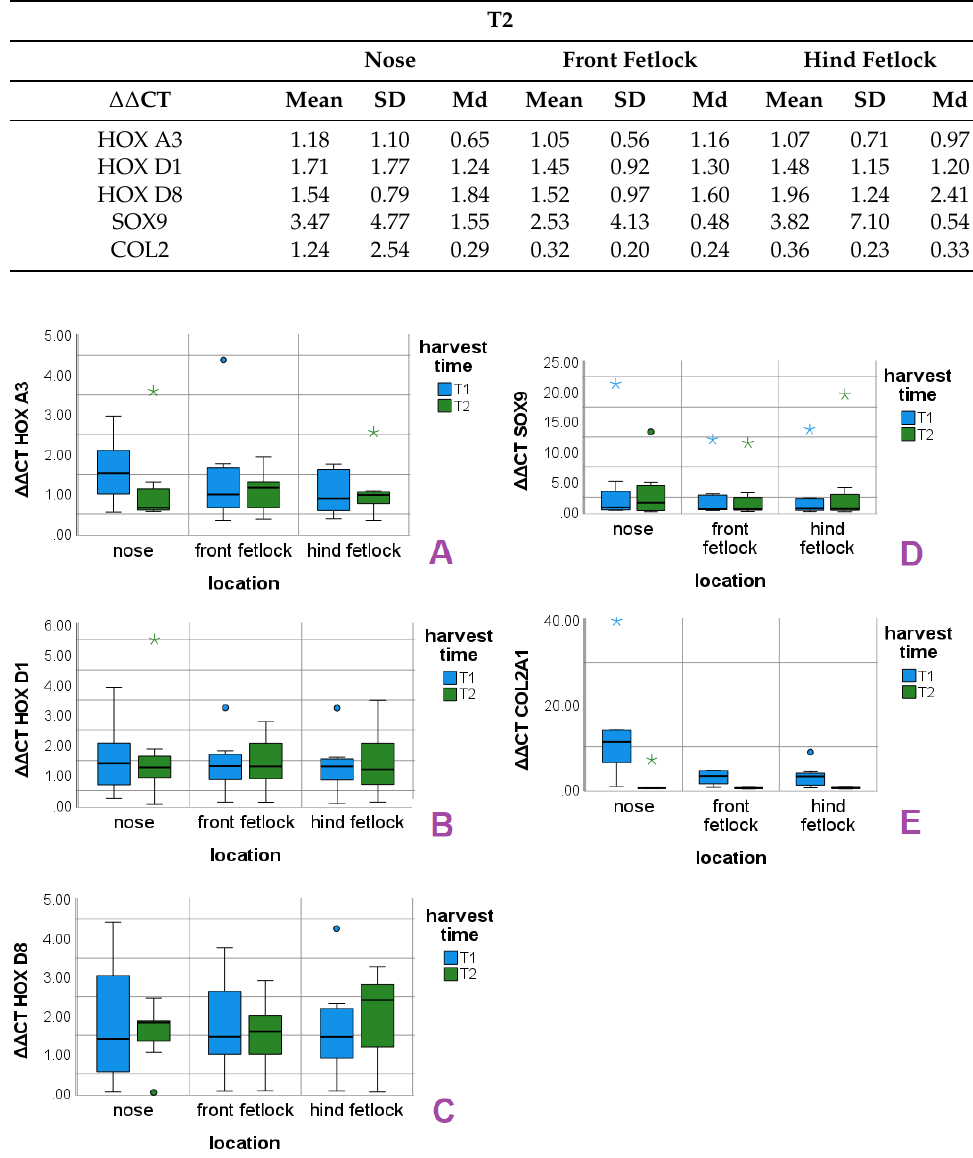
Figure 1. Expression of the HOX genes A3 ( A ), D1 ( B ), D8 ( C ) and the chondrocyte marker genes SOX9 ( D ) and COL2 ( E ) in the three locations at T1 and T2. Dots and asterisks represent outliers and extreme outliers,